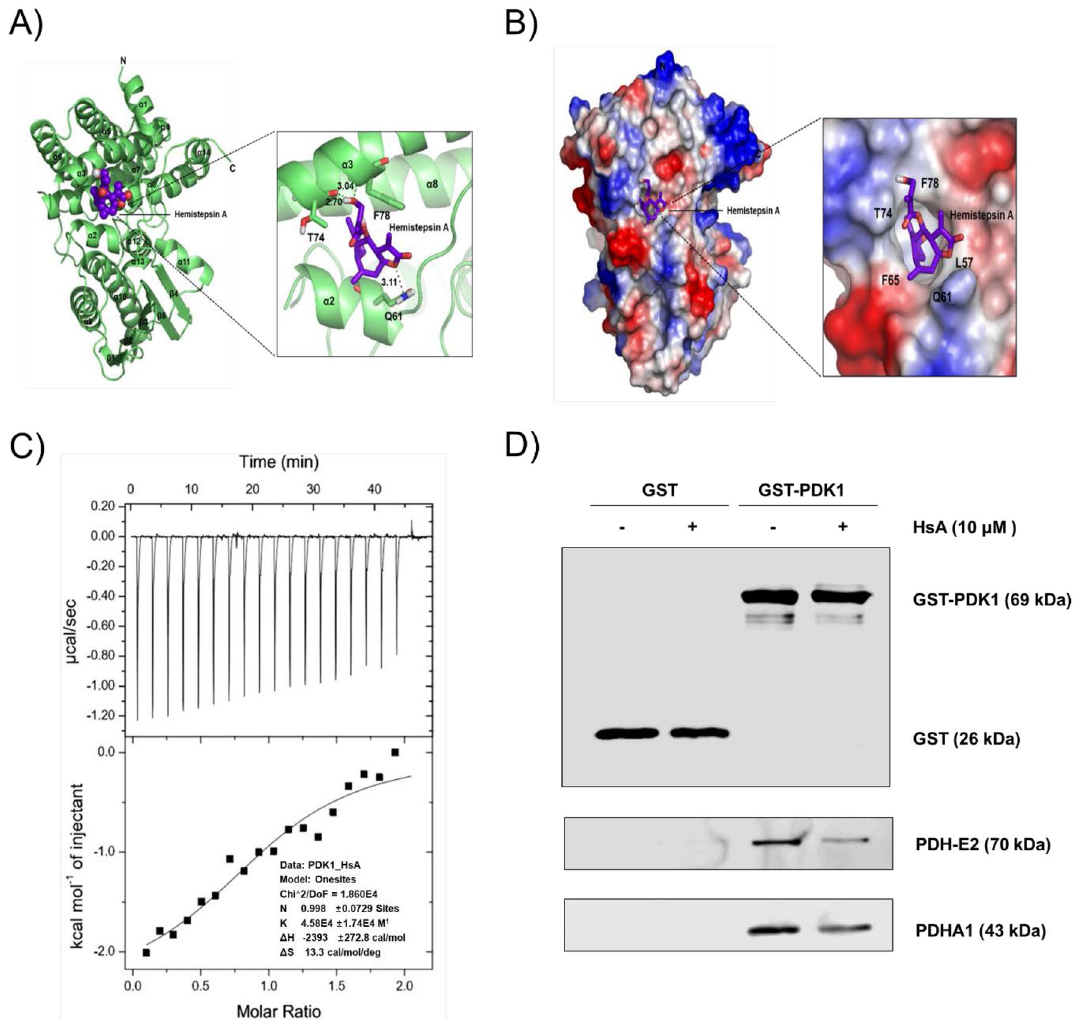
Figure 3. HsA decreases the PDK activity by binding to the lipoamide-binding domain of PDK1. Predicted structure of PDK1 with HsA ( A ) The modeled structure of PDK1 with HsA is shown as a ribbon representation. The interaction residues between PDK1 and HsA are shown and hydrogen bonds are shown as black dotted lines. ( B ) The complex structure of PDK1 with HsA is shown as a surface representation. The relative distribution of the electrostatic surface of PDK1 is shown with the acidic region in red, basic region in blue, and neutral region in white. ( C ) ITC analysis of the PDK1 and HsA interaction is shown. HsA was titrated with PDK1 solution. ( D ) HEK 293T cells transfected with GST and GST-PDK1 were treated with HsA (0, 10 μM) for 12 h. GST and GST-PDK1 fused proteins were pulled down by GST-tagged beads, followed by incubation with whole cell lysates of HEK 293 T cells. The beads were run on SDS-PAGE gel and the levels of PDH-E2 and PDHA1 were measured by Western blot analysis. The amounts of GST and GST-PDK1 were used as a loading